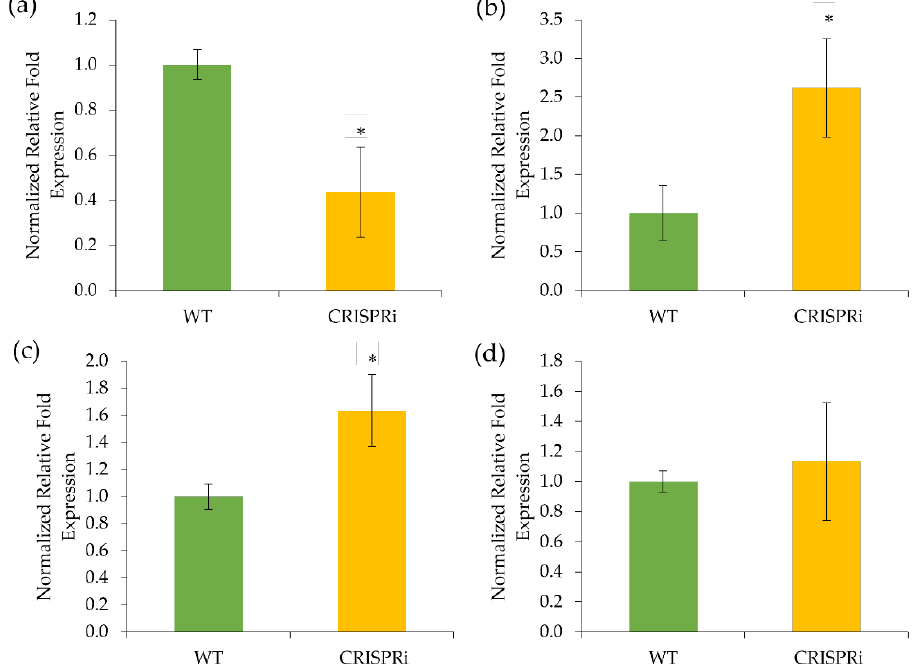
Figure 4. Quantitative real-time PCR analysis of flavonoid-related key enzymes in wild type (WT) and transgenic CRISPRi cell lines of Nicotiana tabacum . ( a ) Cinnamate-4-hydroxylase , ( b ) 4-coumarate ligase , ( c ) chalcone synthase , and ( d ) chalcone isomerase . Data represent the means of three biological replicates (n = 3). Error bars are standard deviation (±SD). Asterisk (*) represents significant differences at p < 0.05 according to paired t -test.